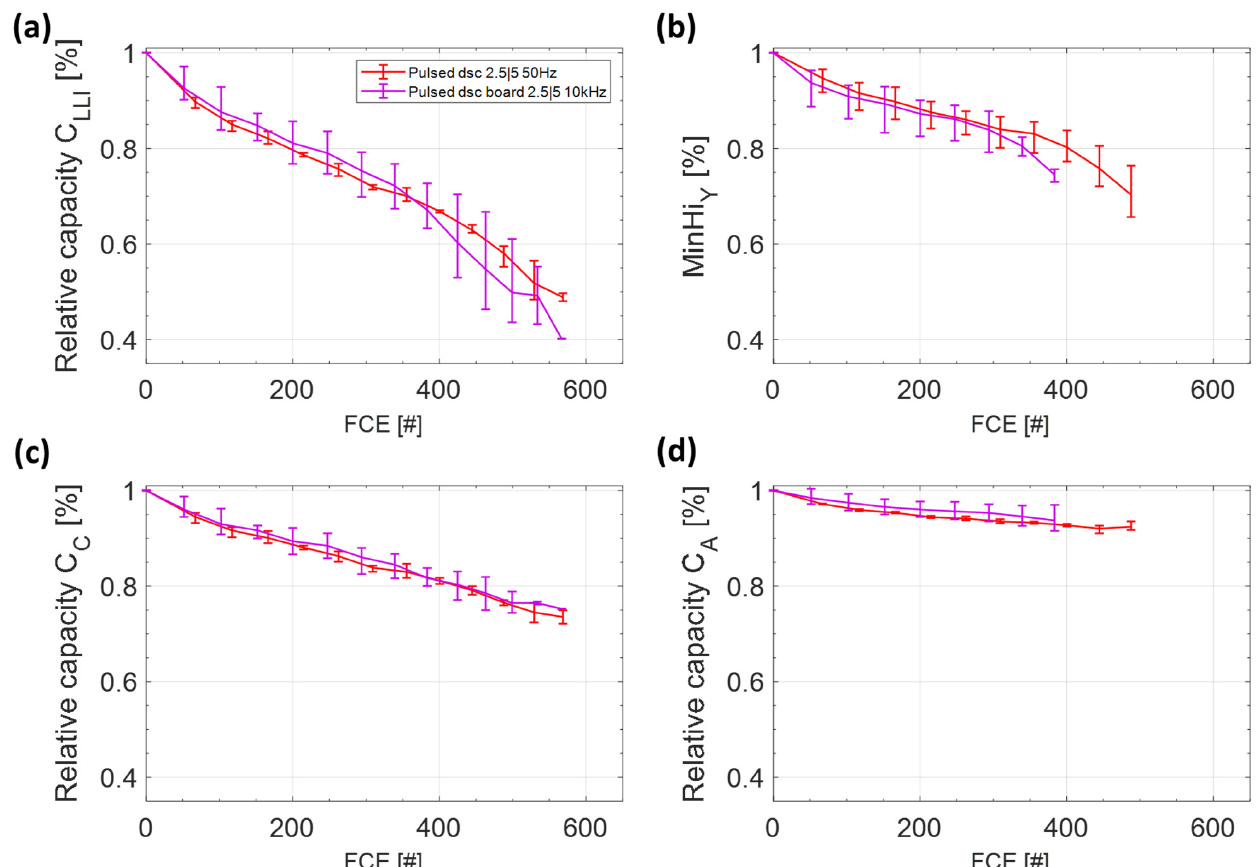
Figure 11. Trends of the loss of active lithium C LLI ( a ) and of the minimum at high SOC (MinHi) ( b ), the cathode C C ( c ) and the relative capacity of the anode C A ( d ) for pulsed discharge at frequencies of 50 Hz (red) and 10 kHz (purple).